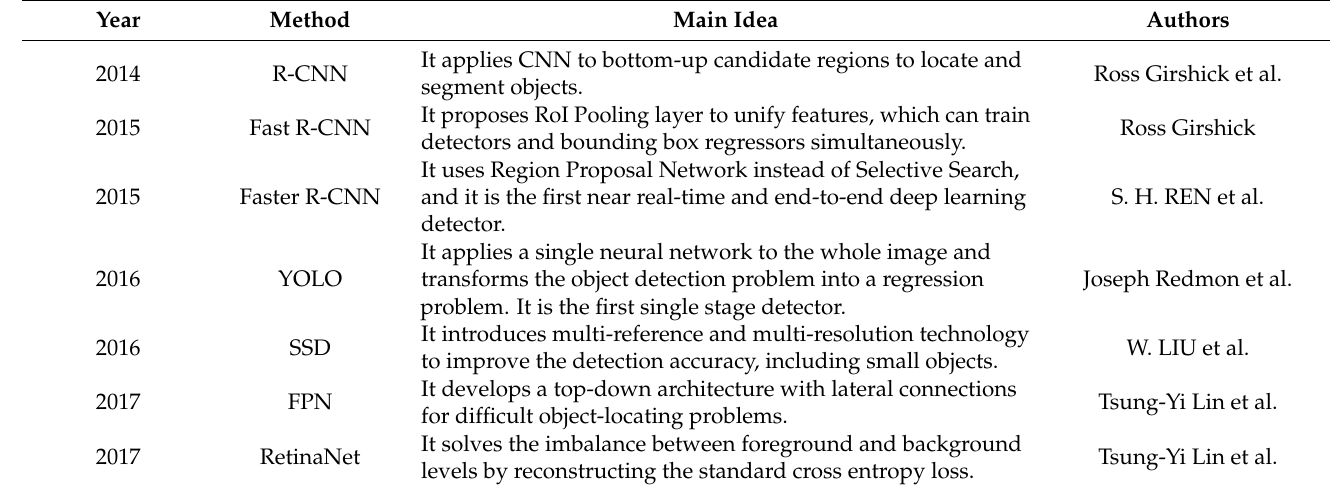
Table 2. Previous work of classical object detection methods